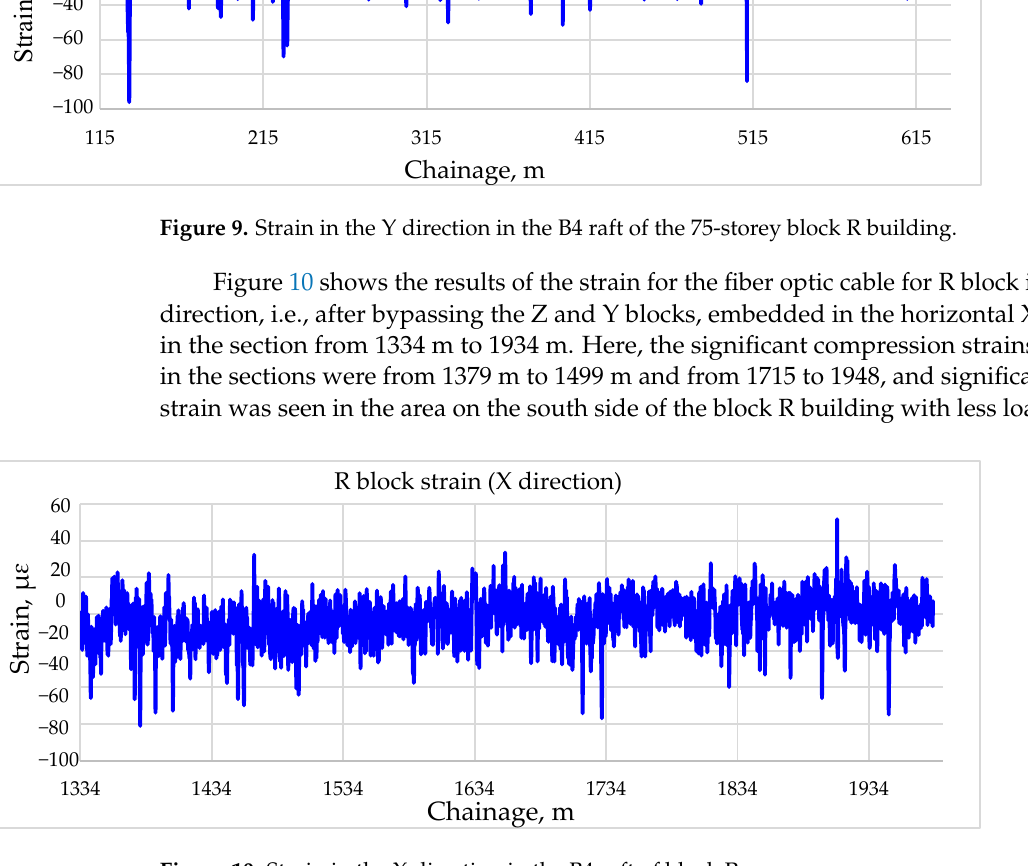
Figure 11. Fiber optic strain along the cable layout in block R, level B4.